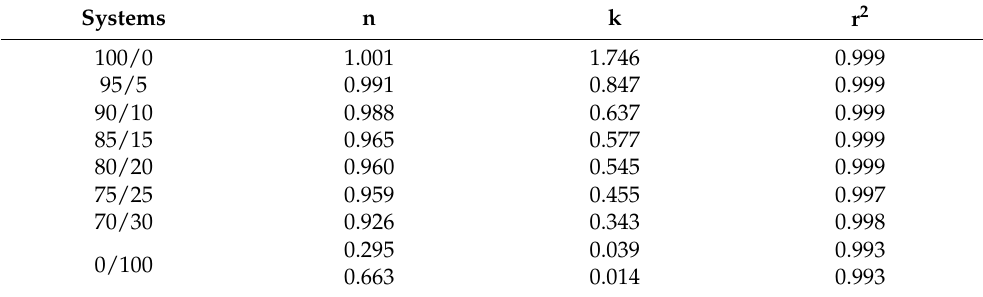
Table 1. Flow behavior index, n, the consistency index, k, and the corresponding regression coeffi- cients (r 2 ), for HPMC/PVP systems at different mixing ratio (wt.%/wt.%).